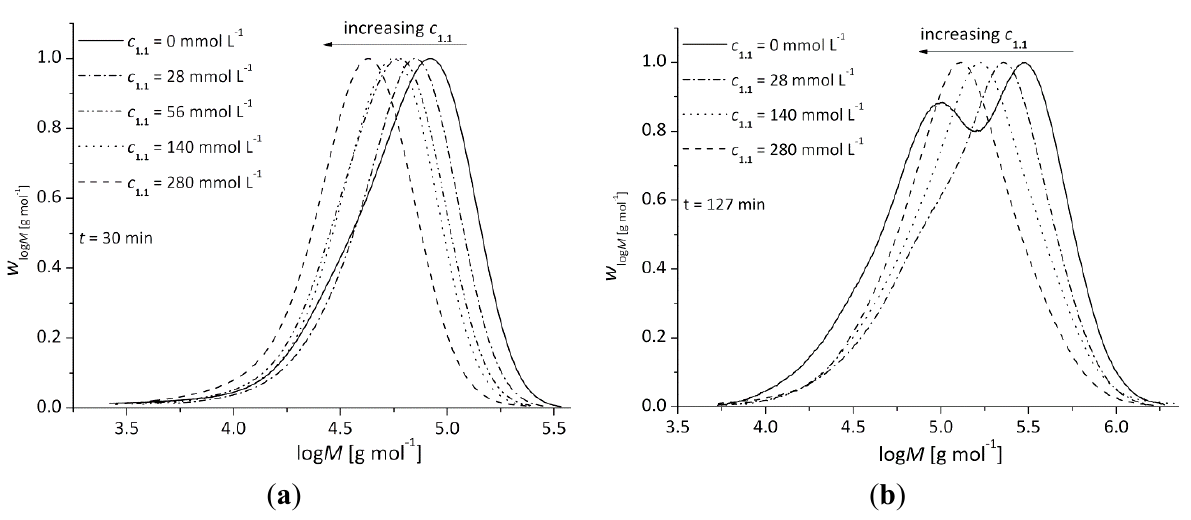
Figure 9. Molar mass distributions (SEC, RI) from different copolymerizations of NIPAm with 1.1 using 0.6 mmol·L − 1 R 3 and 1.1 mmol·L − 1 AIBN in DMF at 60 °C after 6 30 min ( a ) and 127 min ( b